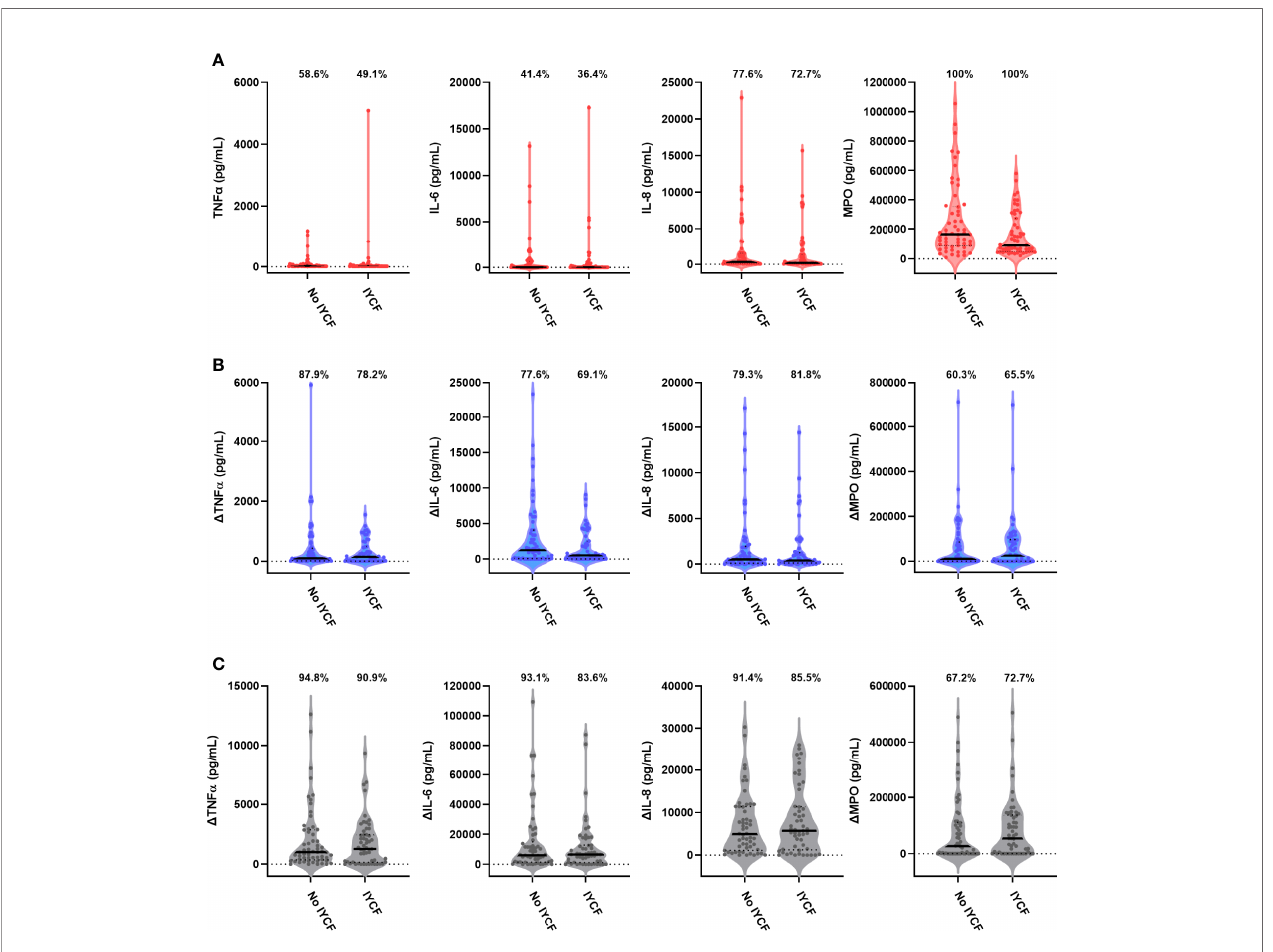
FIGURE 5 | Unstimulated and bacterial antigen-stimulated immune-mediator production by blood immune cells from children exposed versus not exposed to a household IYCF intervention. Violin plots (median and interquartile range indicated) of (A) unstimulated (red), (B) LPS-stimulated (blue) and (C) HKST-stimulated (grey) TNF a , IL-6, IL-8 and MPO concentrations in 24h whole blood culture supernatants. LPS- and HKST-speci fi c concentrations ( D ) were calculated for each child by subtracting concentrations present in matched unstimulated culture supernatants. Proportions indicate participants with mediator concentration > ELISA limit of detection (A) and participants with antigen-stimulated mediator concentration > unstimulated (B, C) . Proportions of children with detectable mediator levels and mediator concentrations were compared between children exposed to the SHINE household IYCF intervention (n = 55) and those not exposed to the IYCF intervention (n = 58) by multinomial logit regression and censored log-normal (tobit) regression, respectively (unadjusted analyses indicated; full results in Table 5